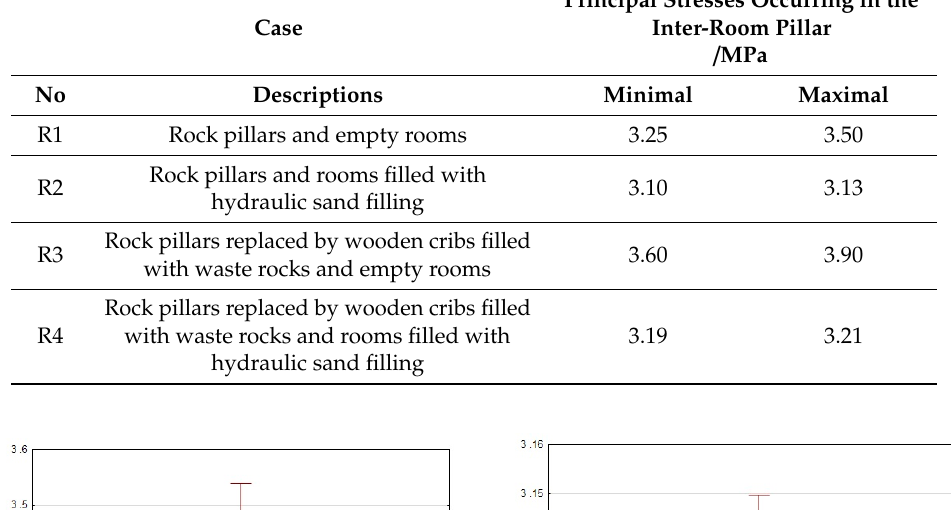
Table 2. Summary of numerical modeling results for four cases.